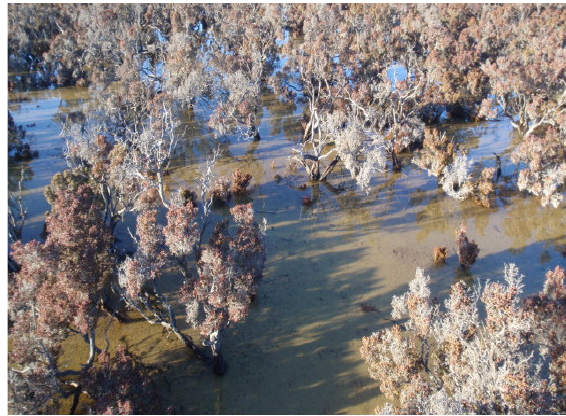
Figure 3: Inundated site with dense coverage of emergent halophytic vegetation.